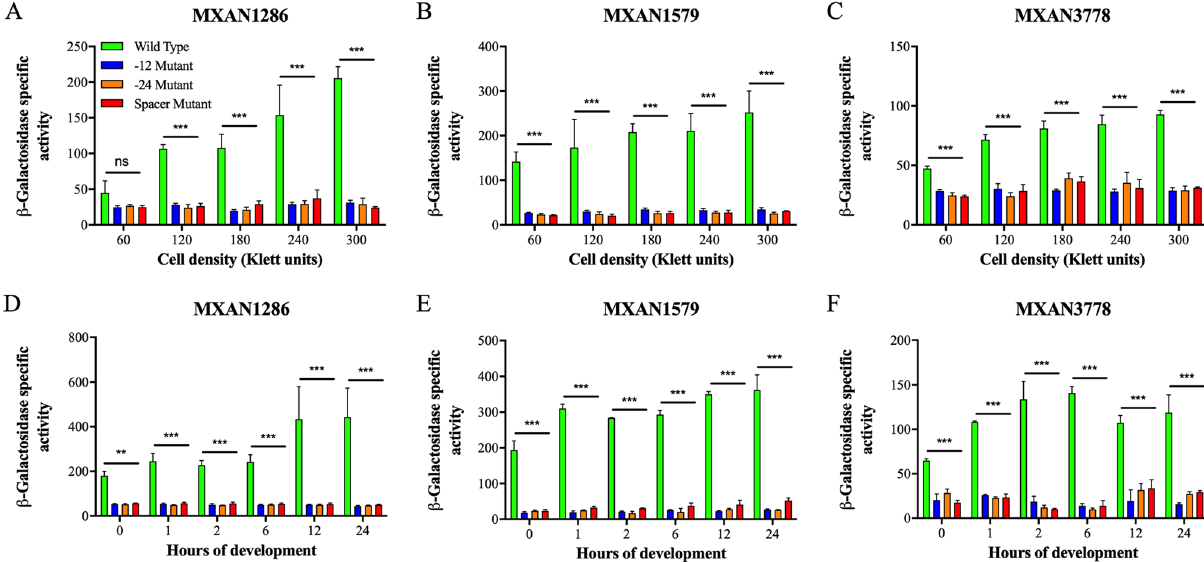
Figure 3. In vivo activities of wild-type MXAN1286, MXAN1579 and MXAN3778 promoters and derivatives of the promoters carrying a mutation in the putative − 12-bp region, − 24-bp region or spacer region. Wild- type and mutant fragments of the MXAN1286, MXAN1579 and MXAN3778 promoters were cloned into a lacZ expression vector and transferred to the wild-type M. xanthus strain DK1622. At various cell densities during growth ( A – C ) and time points during development ( D – F ), β-galactosidase-specific activities (defined as nanomoles of ONP produced per minute per milligram of protein) in cells carrying a wild-type or a mutant promoter fragment were determined. (N = 3 at each density or time point; error bars are standard deviations of the means; ***p < 0.001; **p < 0.01; *p < 0.05 for in vivo activities of mutant promoters versus wild-type